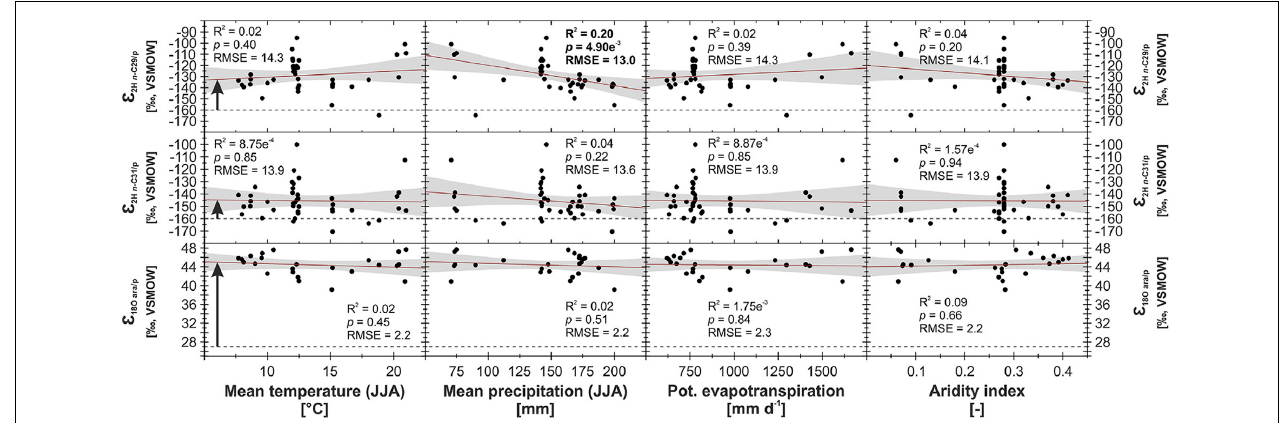
ε ε ε FIGURE 4 | Apparent fractionation 2H n - C 29 / p , 2H n - C 31 / p and 18O ara / p from the topsoil transect through Mongolia plotted against T JJA , P JJA , Et 0 , AI (Fick and Hijmans, 2017; Trabucco and Zomer, 2019). Red trend lines illustrate linear regressions, gray shaded areas the 95% confidence interval. Bold R 2 / p -values indicate the level of significance ( α = 0.05). Black dashed lines illustrate values for the biosynthetic fractionation, and black arrows indicate the effect of evapotranspirative enrichment (biosynthetic fractionation factors of − 160 and +27 are assumed for the n -alkanes and arabinose, (cid:104)